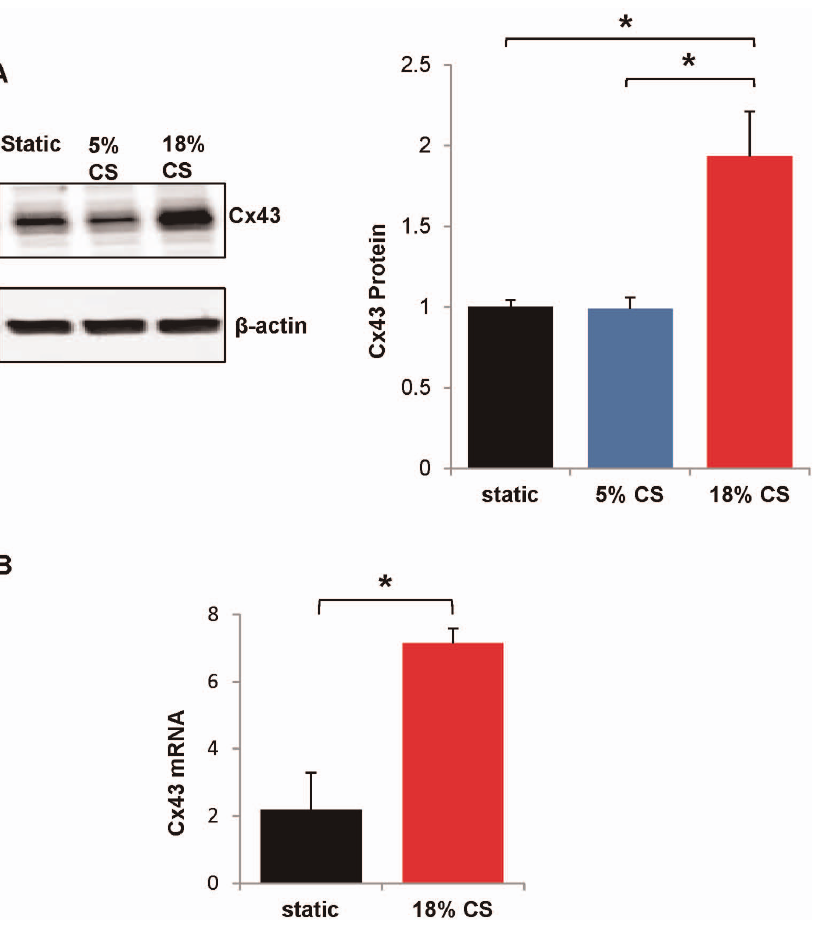
Figure 5. Cyclic stretch increases Cx43 expression. HPAECs were grown to confluence on flexible Bioflex plates; subjected to pathological cyclic stretch (18% elongation), physiological cyclic stretch (5% elongation), or static stretch (0% elongation) for 24 hr.; and Cx43 protein or mRNA was measured. A.) 18% cyclic stretch (18% C.S.) is compared to physiological (5%) stretch control (5% C.S.) and static stretch control. A representative Western blot is shown. Cx43 is normalized to b -actin housekeeping protein levels and expressed relative to static stretch. *, p , 0.05. n=7 for 18% stretch and static stretch; n=5 for 5% stretch. B.) To measure Cx43 mRNA, cells were subjected to 18% cyclic stretch or static stretch control as before and samples were analyzed by qRT-PCR. Cx43 mRNA was normalized to GAPDH housekeeping mRNA. n=6. *p ,